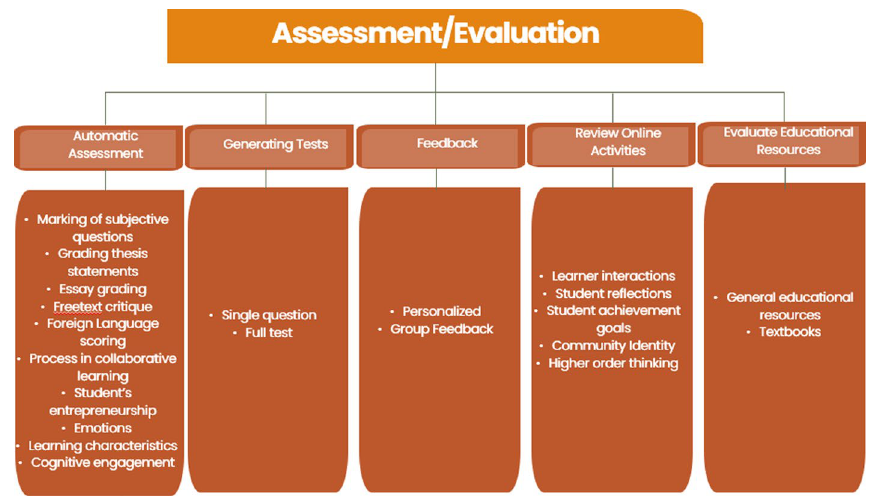
Fig. 8 Codes and axial codes for assessment and